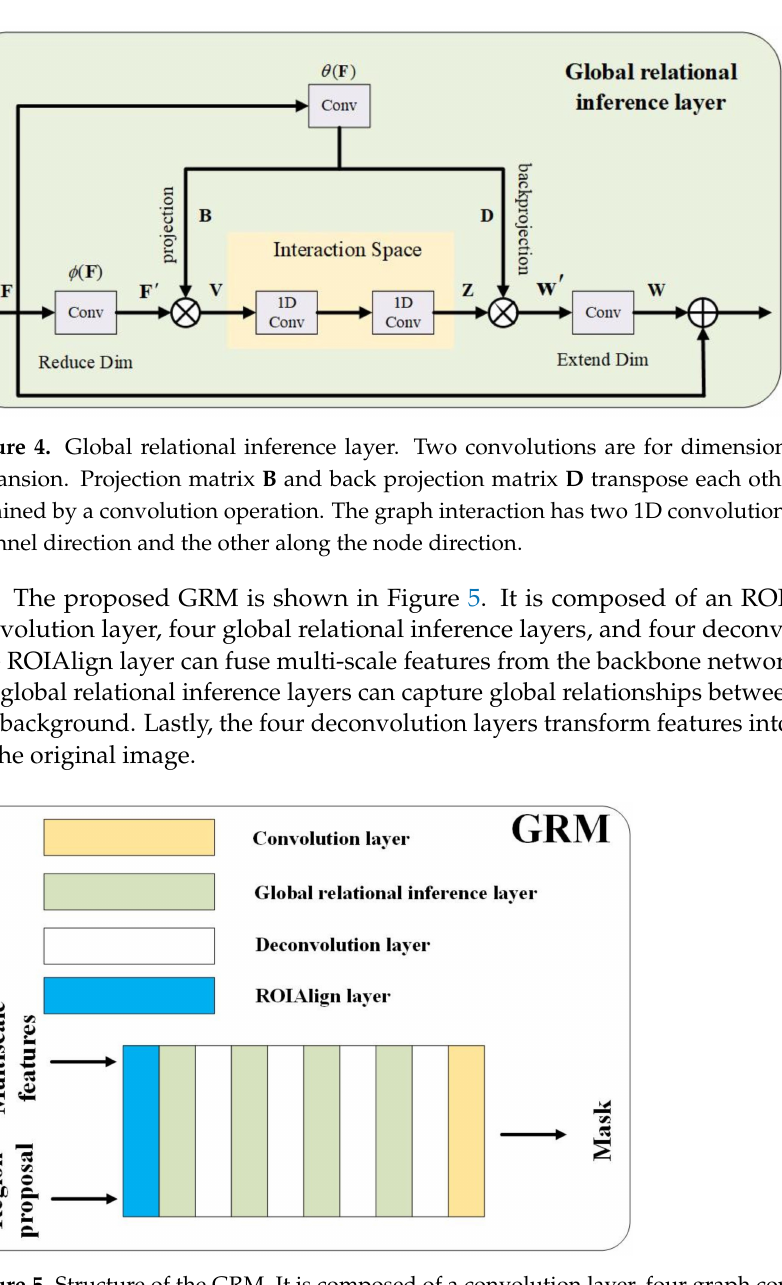
Figure 5. Structure of the GRM. It is composed of a convolution layer, four graph convolution layers, four deconvolution layers, and an ROIAlign